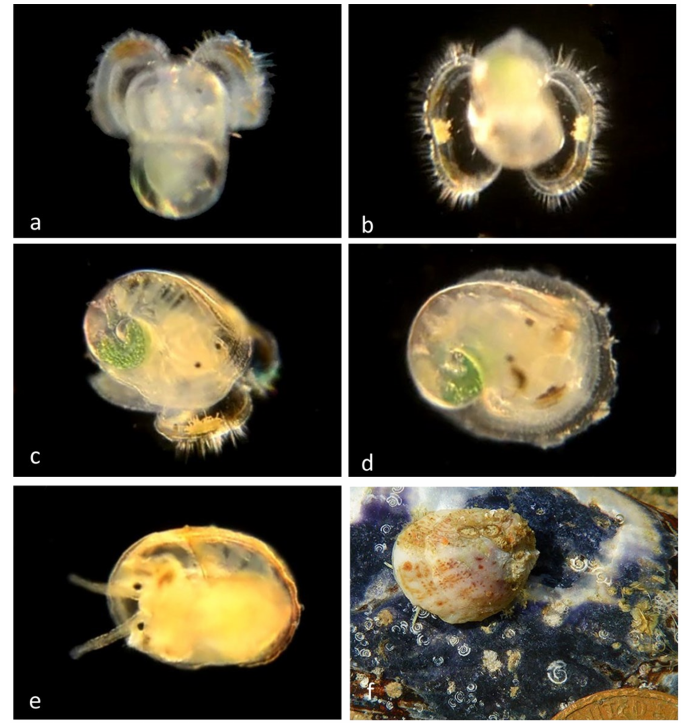
Figure 7. Family Calyptraeidae. Slipper snail , Crepipatella lingulata. (BIN AAF2329; n = 27 veligers, 4 pre-adults, 2 adults) ( a ) Veliger CCDB-24236-E04 from Little Treasure Cove, Crystal Cove State Park. ( b ) Veliger CCDB 31597 F05 from Newport Beach harbor entrance. ( c ) Late veliger BIOUG01229-F06 from Newport Beach harbor entrance. ( d ) Juvenile CCDB-24722-H11 from Newport Beach harbor entrance. ( e ) Juvenile BIOUG01229-F02 from Newport Beach harbor entrance, ( f ) Adult CCDB-32336 G10, dorsal, from Shaw’s Cove south, Laguna Beach.